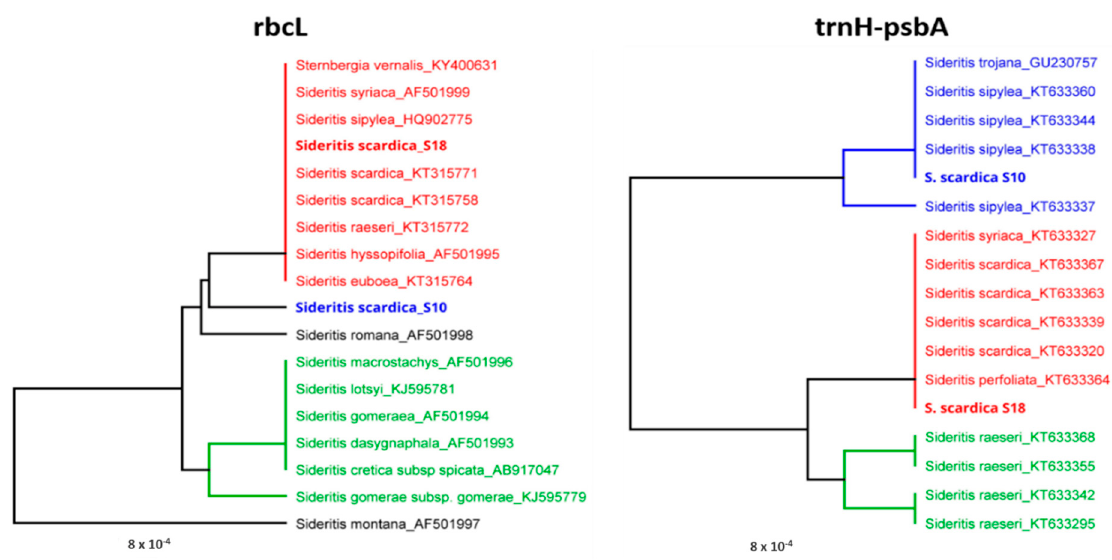
Figure 6. Taxonomic assignment of region-specific Sideritis scardica specimens (S10 and S18, in bold) against BOLD database accessions (trnH-psbA) and BOLD+NCBI (rbcL). The trees were constructed in Geneious software using the genetic distance model of Jukes–Cantor and the tree construction method of UPGMA.